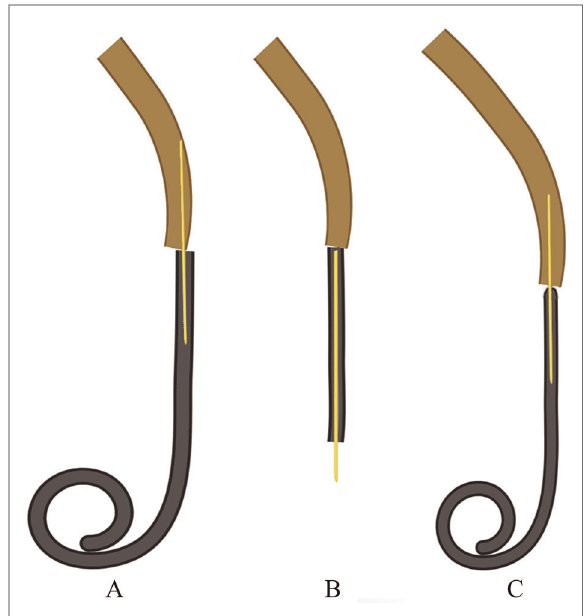
FIGURE 1 Pattern diagram of the properties of guidewire and double J stents (DJSs). ( A ) Inner diameter of the DJS is too large so the guidewire cannot fi t the stent perfectly, which leads to DJS stuck at the ureteral ori fi ce (arrow). ( B ) Another kind of a DJS with a blind proximal coil, which needs to be placed with a guidewire against its end. ( C ) DJS has a blunt-end design (arrow), and the inner diameter matches well with the guidewire, which can make the insertion safer and more